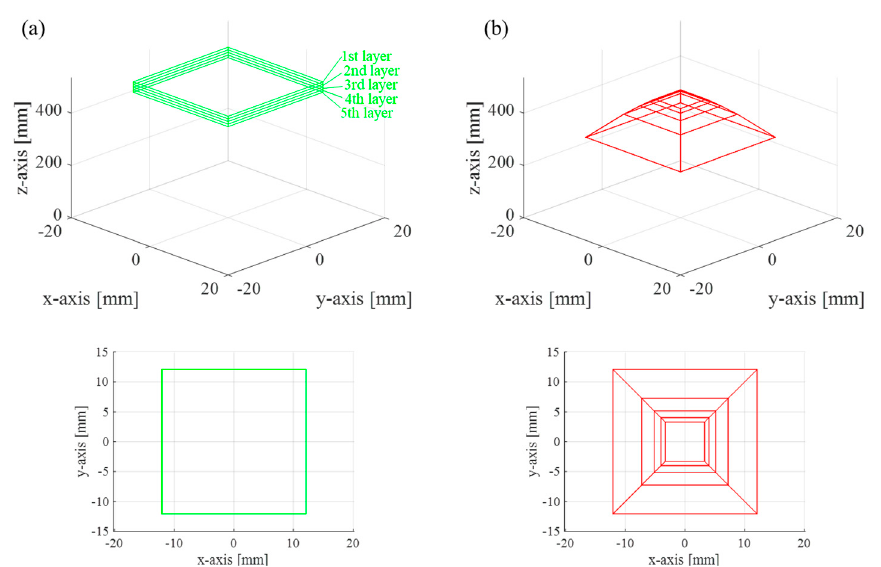
Figure 2. Spatial distortion relation of SIDH. ( a ) Target layered rectangle objects in the real space and ( b ) corresponding distorted objects reconstructed from the incoherent hologram recorded by the proposed SIDH system. The depth set along the z -axis of the real object is 520 mm, 510 mm, 500 mm, 490 mm, and 480 mm. The depth set of the reconstructed object is 307.5 mm, 396 mm, 427.8 mm, 443.9 mm, and 453.5 mm. The system parameters are set to d 1 = 525 mm, d 2 = 15 mm, and f = 250